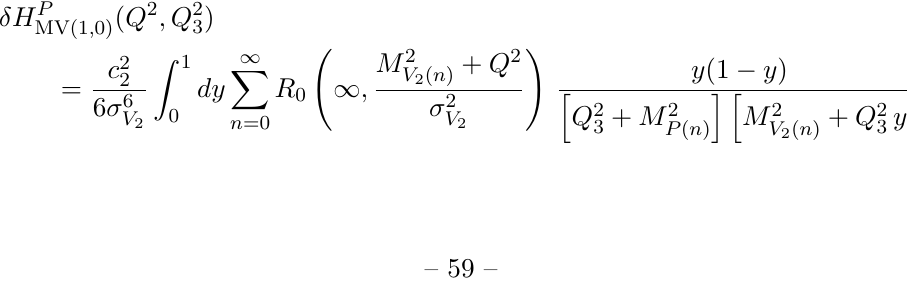
Figure 20. Numerical checks for the validity of commuting the expansion in Q 2 and Q 2 integration over y in (C.19). In all cases, we can see that when r ! 1 (MV kinematics), the curves tend to the coe(cid:14)cients obtained by expanding in the virtualities (cid:12)rst and then integrating over the Feynman parameter y . Note that the scales on the y -axis vary between the